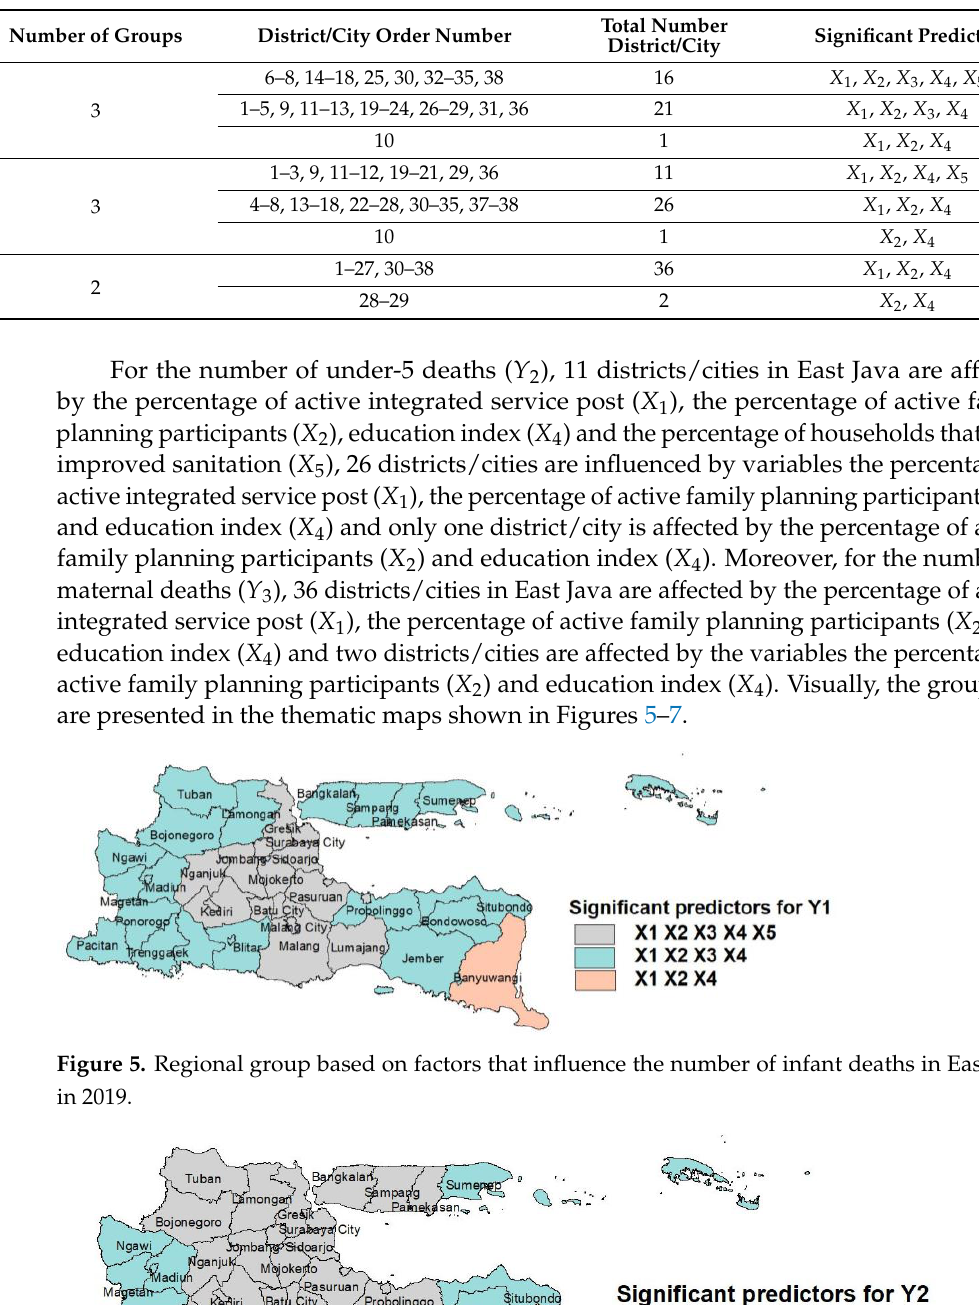
Table 7. Regional groups based on significant predictors by the GWMPIGR model 1.